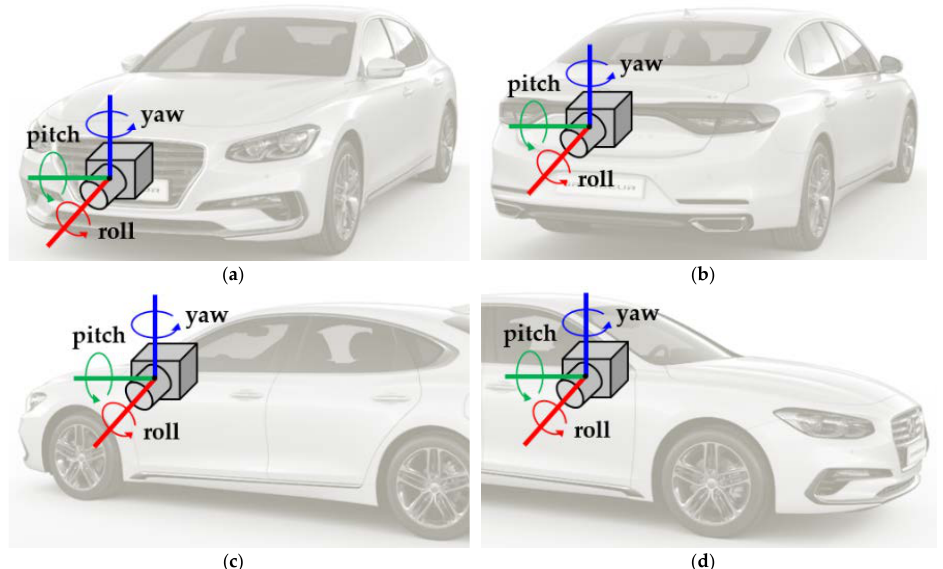
Figure 8. Pitch, yaw, and roll of four cameras composing the AVM system. ( a ) Front camera; ( b ) Rear camera; ( c ) Left camera; ( d ) Right camera.